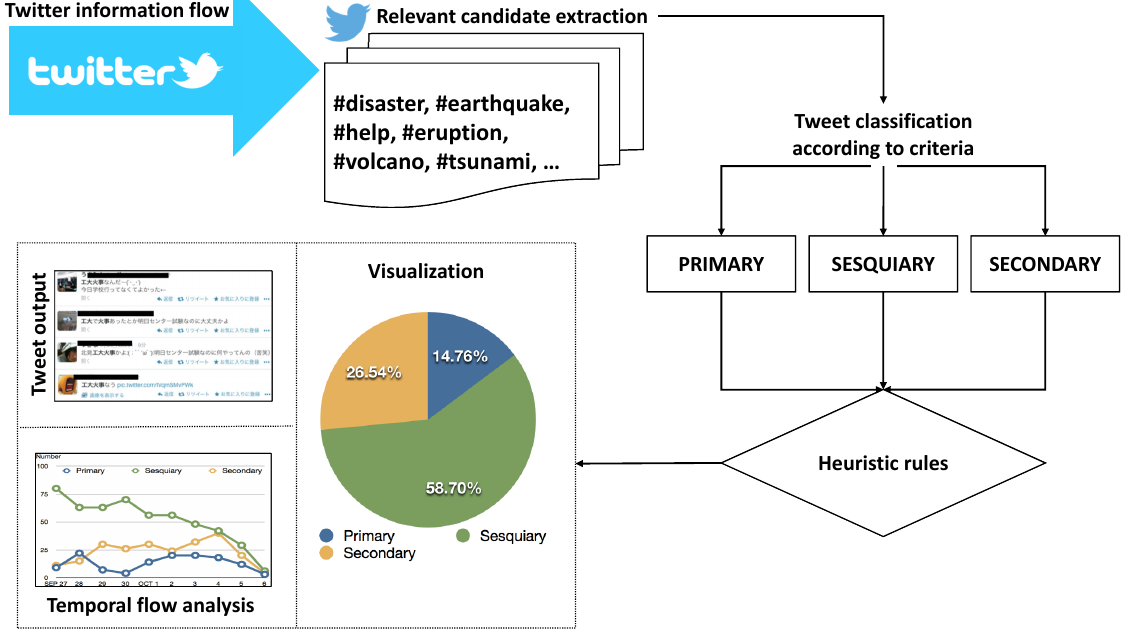
Figure 9. Outline of the